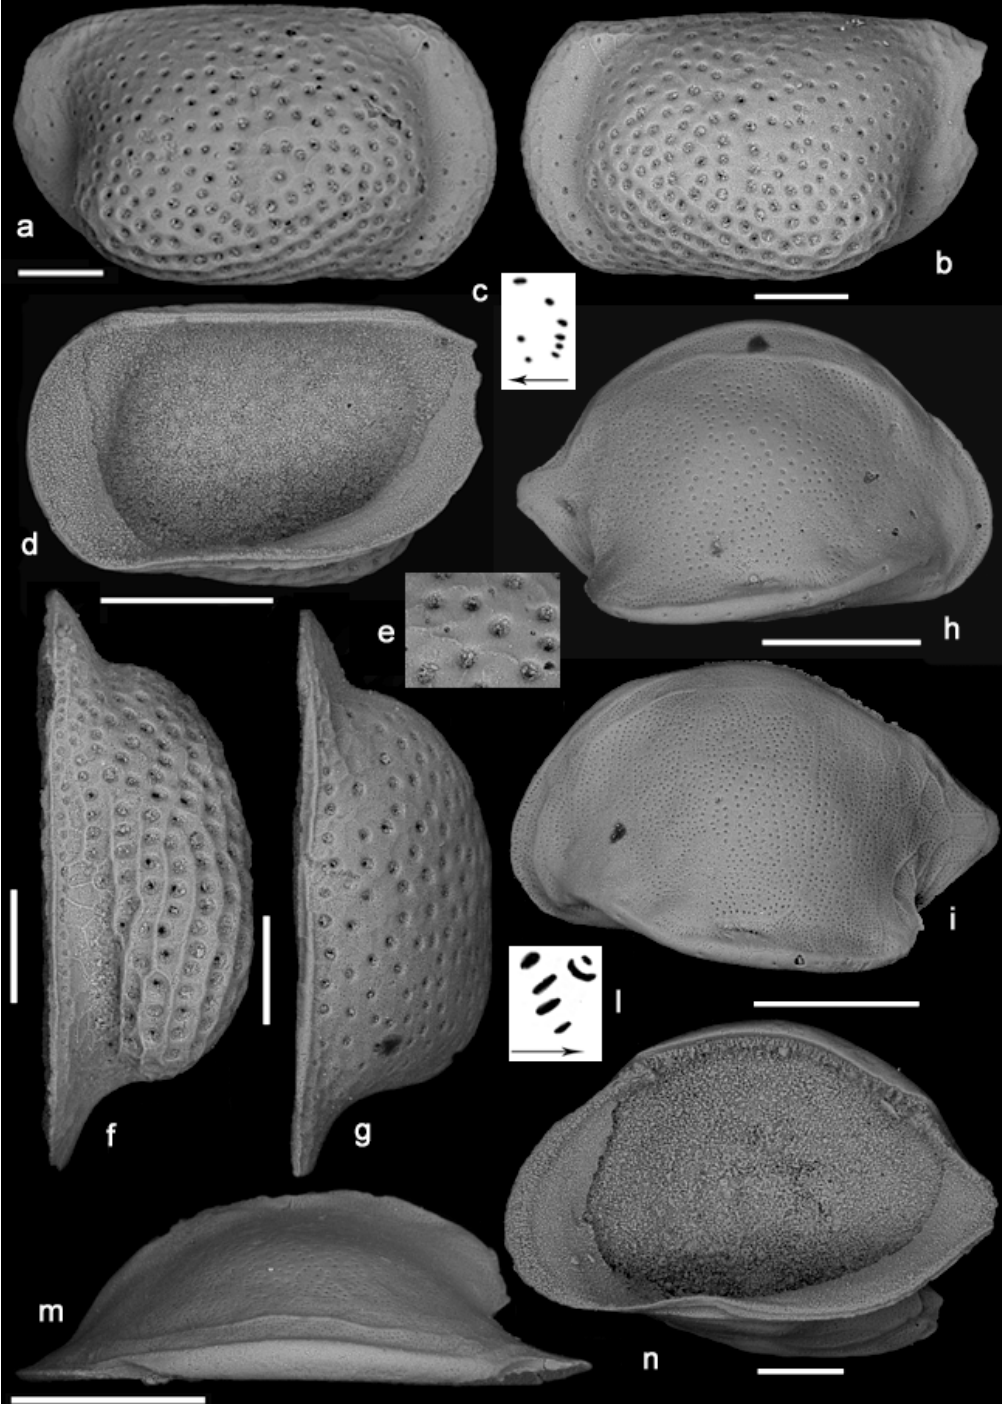
Figure 3. ( a – g ) Bythocythere solisdeus n. sp.: ( a ) Right valve in lateral view (scale bar 100 μ m); ( b ) Left valve in lateral view (scale bar 100 μ m); ( c ) Muscle scars (drawing); ( d ) Right valve, internal view (scale bar 200 μ m); ( e ) Normal pores; ( f ) Left valve in ventral view (scale bar 100 μ m); ( g ) Right valve in dorsal view (scale bar 100 μ m); ( h–n ) Cytheropteron eleonorae n. sp.: ( h ) Right valve in lateral view (scale bar 200 μ m); ( i ) Left valve in lateral view (scale bar 200 μ m); ( l ) Muscle scars (drawing); ( m ) Right valve in dorsal view (scale bar 100 μ m); ( n ) Right valve, internal view (scale bar 100 μ